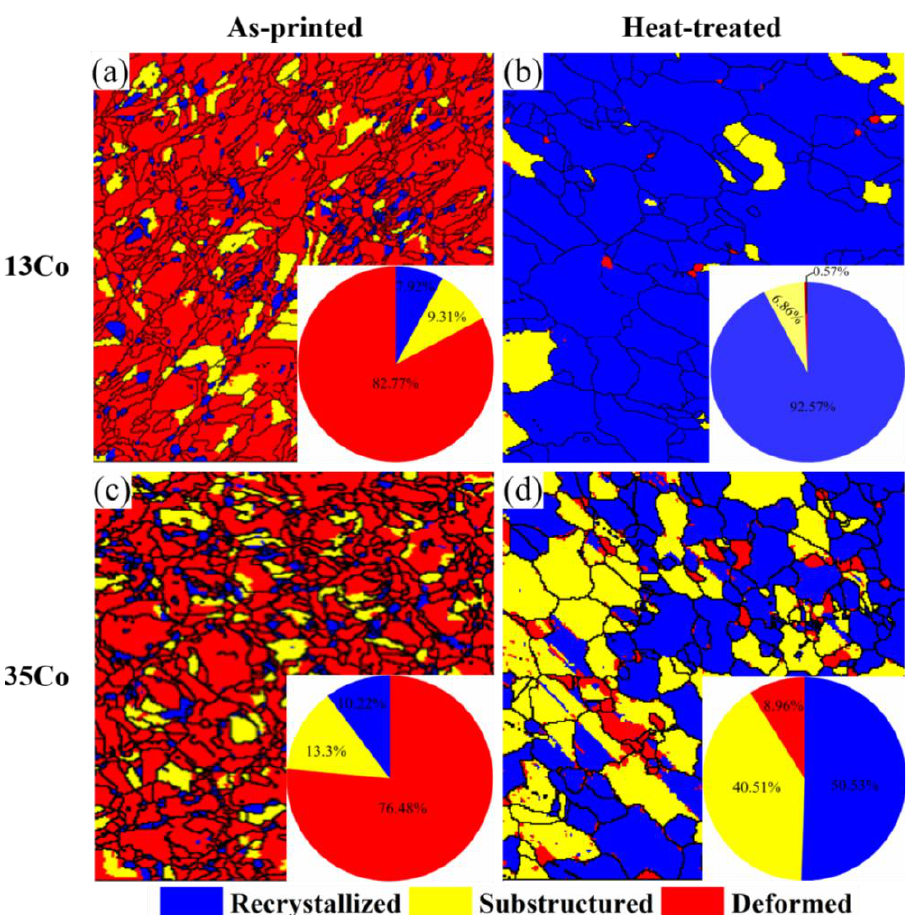
Figure 4. Recrystallization diagram of the XZ planes in ( a ) the as-printed 13Co, ( b ) heat-treated 13Co, ( c ) as-printed 35Co, and ( d ) heat-treated 35Co with recrystallized, substructured, and deformed grains.